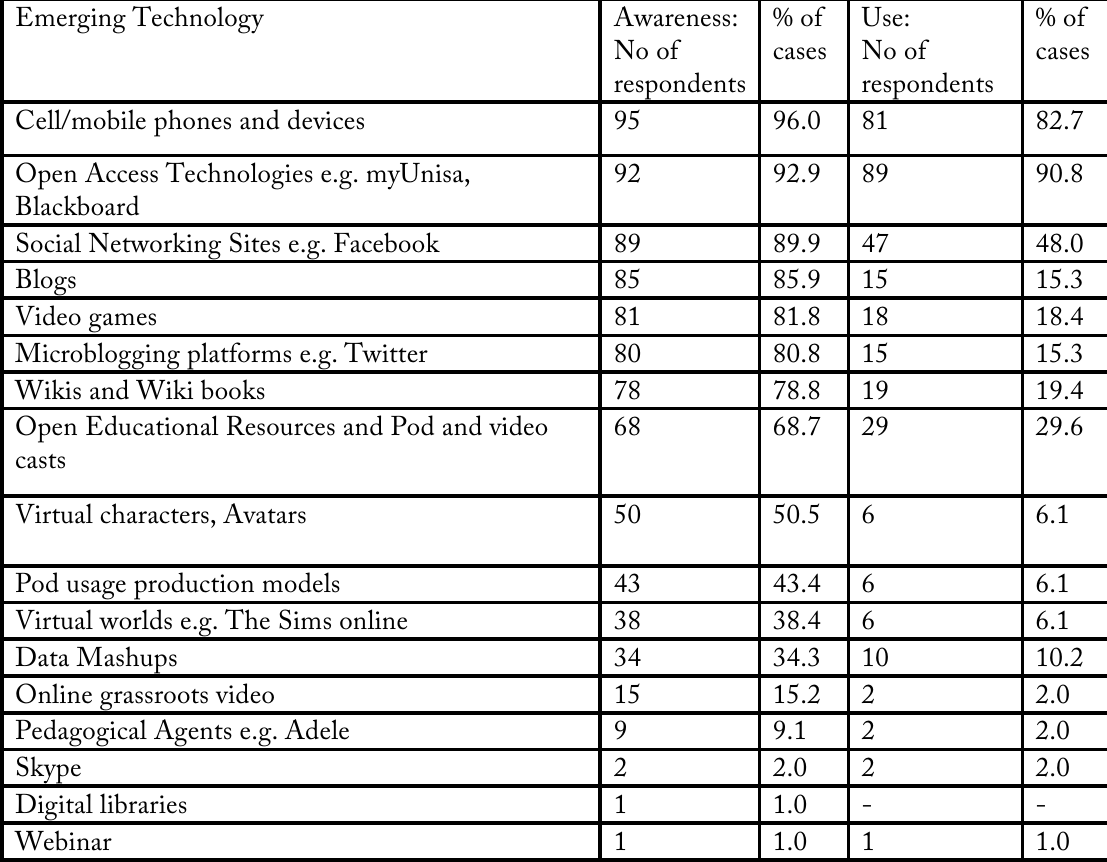
Table 5: Awareness (N = 99) and Use (N = 98) of emerging technologies by the respondents Emerging Technology